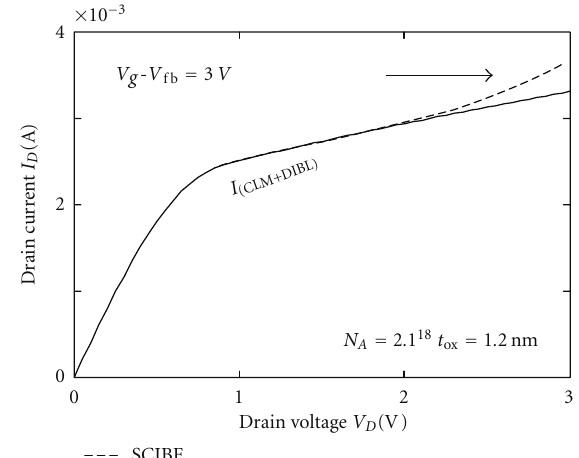
Figure 16: An example of SCIBE ( L = 90nm; W/L = 10).